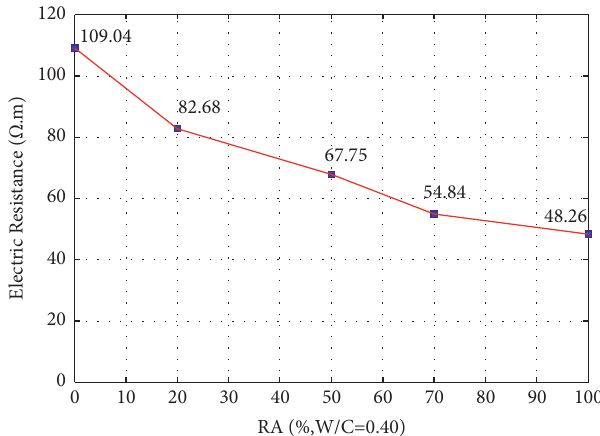
Figure 8: Electric resistance-RA relationship.